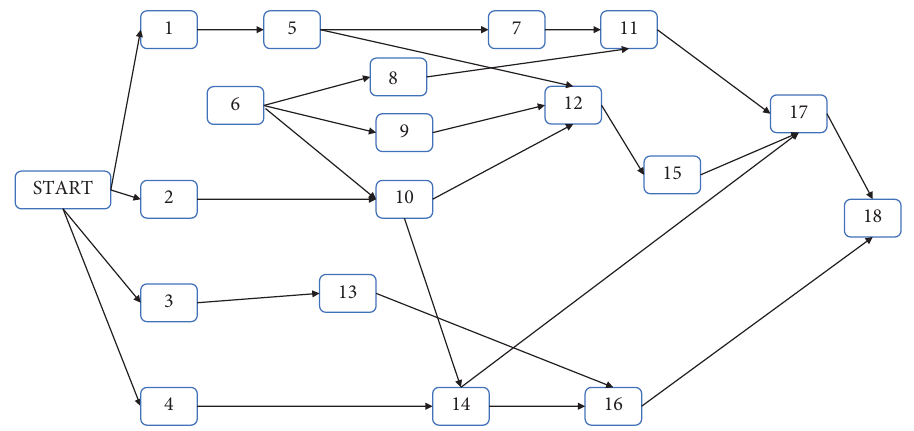
Figure 3: Case 2 network. Table 5: Result Pareto-optimal solutions for case